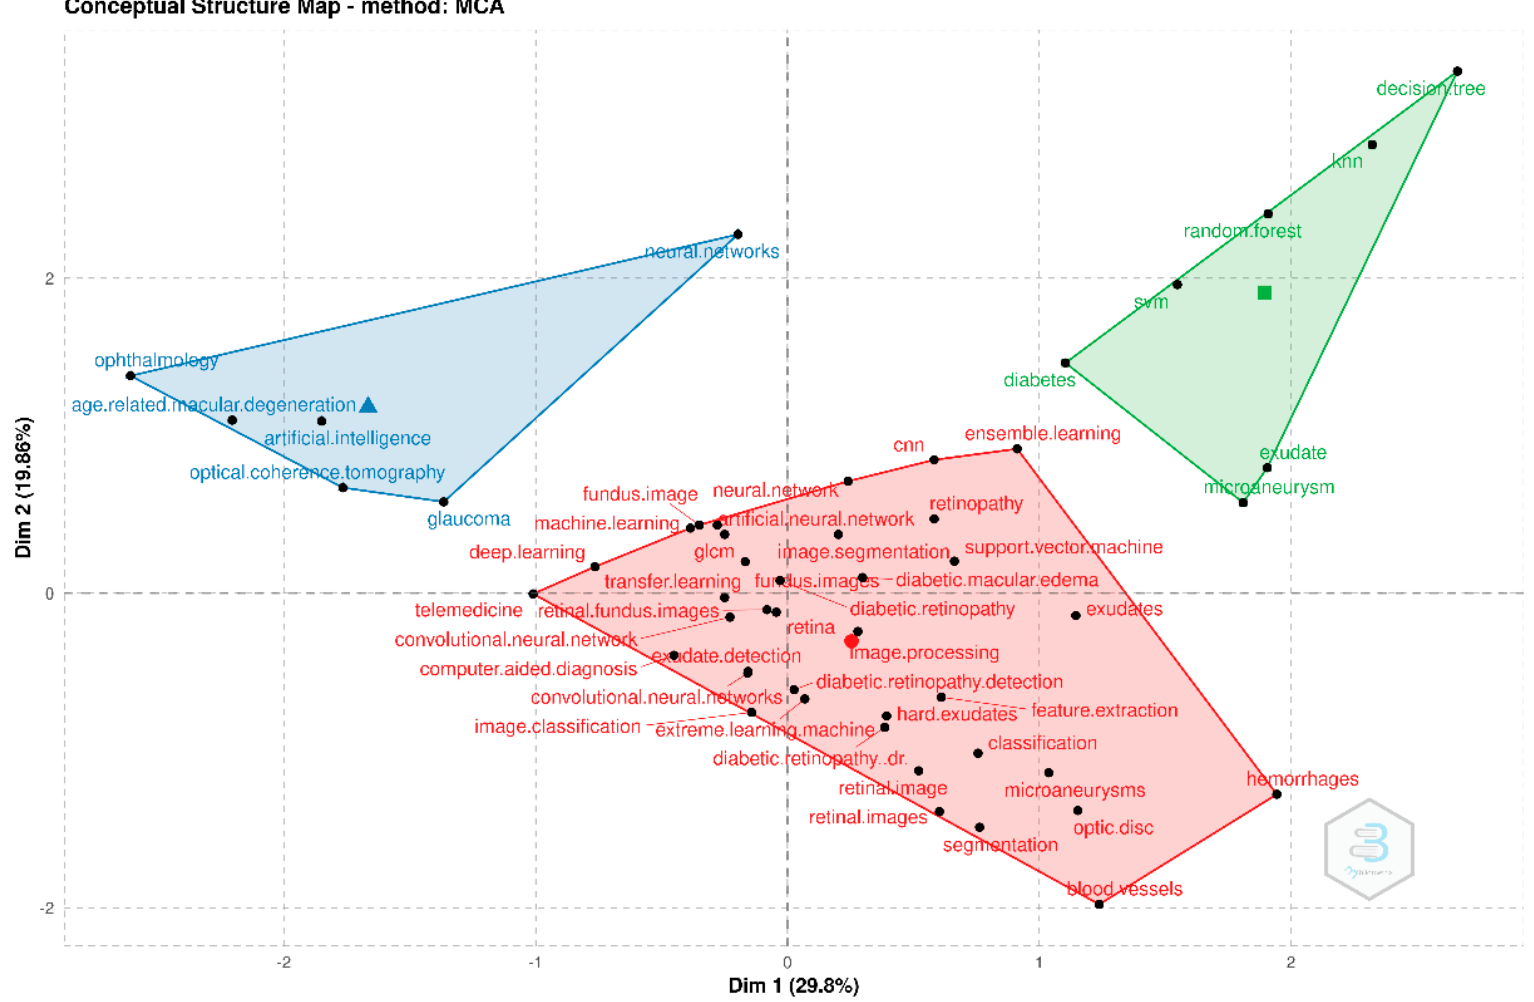
Figure 16. Factorial map.